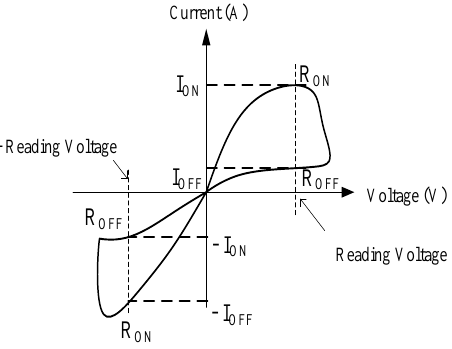
Figure 1. Standard I-V curve of a memristor device in a form of pinched hysteresis with ‘ON’ current and ‘OFF’ current position.